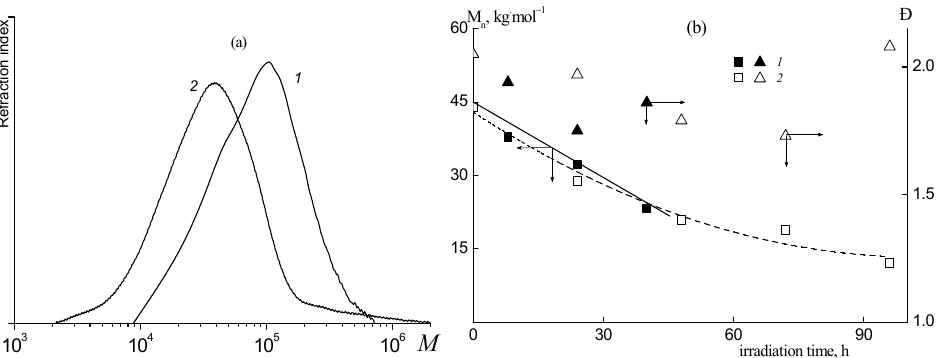
Figure 10. ( a ) SEC curves of poly(BVK) initial (1) and after irradiation for 40 h (2); ( b ) dependence of M n of poly(BVK) on irradiation time at poly(BVK) concentration 2.5 (1) and 1.25 mg/mL.